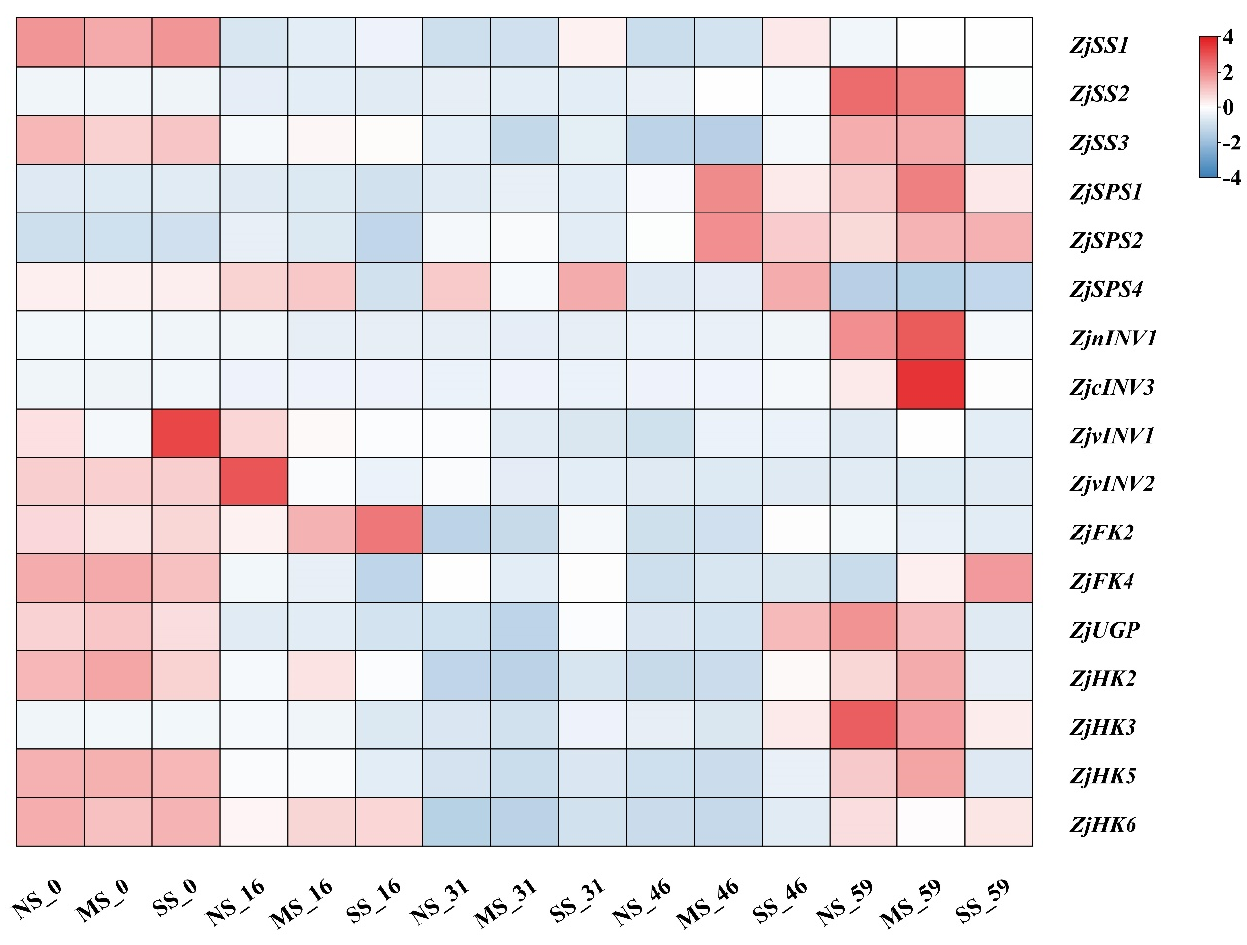
Figure 5. Heatmap analyses of gene expression involved in sugar metabolism in fruits. Sucrose synthase (SS), sucrose phosphosynthase (SPS), invertase (INV), fructokinase (FK), pyrophosphorylase (UGP), hexokinase (HK).